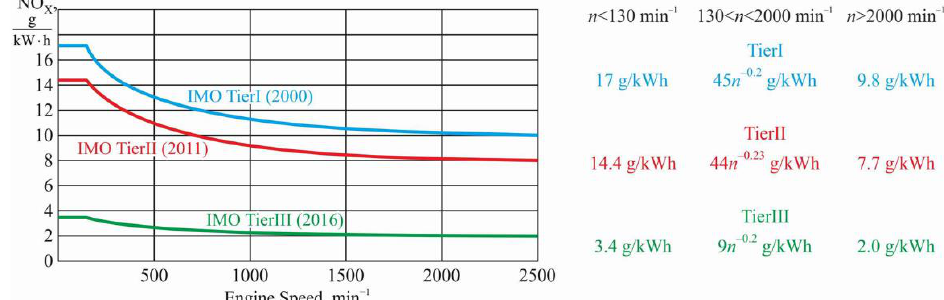
Figure 2. Requirements Annex VI MARPOL of quantity NO X in the exhaust gases of marine diesel engines.